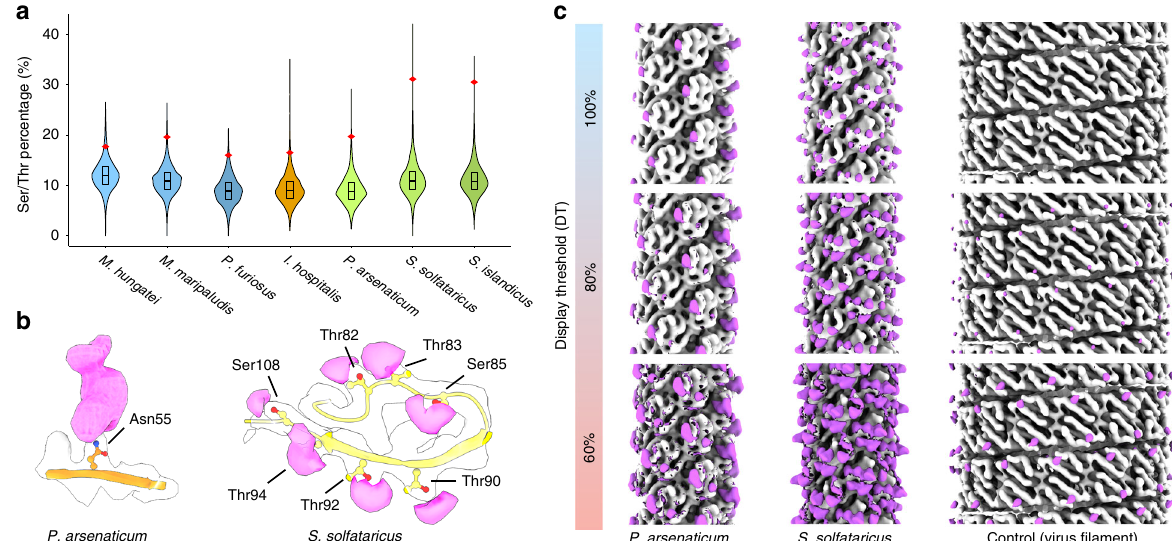
Fig. 3 Glycosylation of archaeal type IV pilus and other archaeal cell appendages. a Violin plot showing the distributions of the serine and threonine percentages in all proteins of M. hungatei , M. maripaludis , P. furiosus , I. hospitalis , P. arsenaticum , S. solfataricus and S. islandicus . The red diamond indicates the percentage of serine + threonine in the pilin or fl agellin from this species discussed in this paper. The black box indicates the interquartile range, and the central line in the box indicates the median of the data. The species for the archaeal fl agellar fi laments are colored in blue-ish colors, adhesion fi laments in orange, and archaeal T4P in green-ish colors. b Density (magenta) due to post-translational modi fi cations on P. arsenaticum pilin (left) and S. solfataricus pilin (right). The protein C α backbone is colored in orange ( P. arsenaticum ) or yellow ( S. solfataricus ). The extra density is due to N-linked (Asn) or O-linked (Thr, Ser) sugars, and the residues modi fi ed are labeled. c Surface glycosylation of the P. arsenaticum pilus (left), S. solfataricus pilus (middle) and a control rod-like virus without apparent glycosylation. The control virus and the S. solfataricus pilus were puri fi ed and imaged together. All three volumes were fi ltered to 7 Å. The density accounted for by atomic models is colored in gray, and the extra density is colored in magenta. Three different display thresholds are shown. A small additional density appears on the surface of the virus, and this is due to several C-terminal residues that were not part of the atomic model due to disorder, and not due to